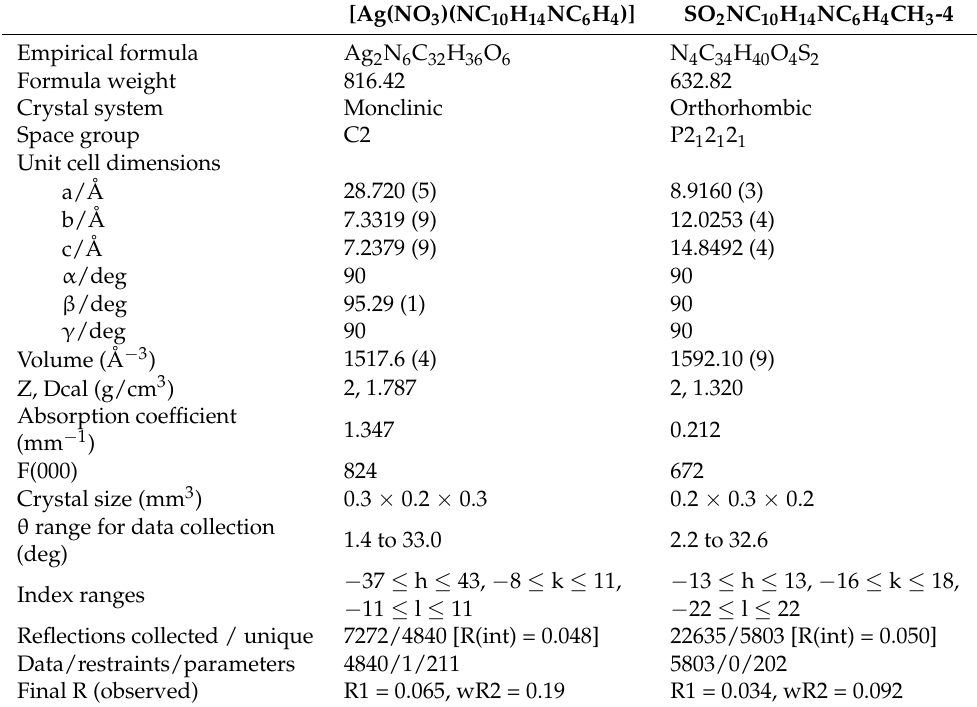
Table 2. Crystallographic data for [Ag(NO 3 )(NC 10 H 14 NC 6 H 4 )] ( 6a ) and SO 2 NC 10 H 14 NC 6 H 4 CH 3 ( 11